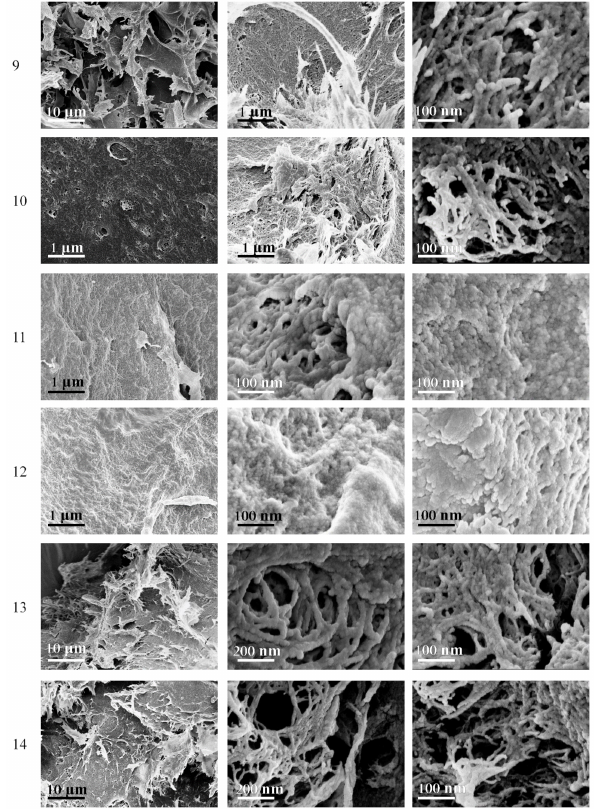
Figure 5. SEM images of cryogel samples